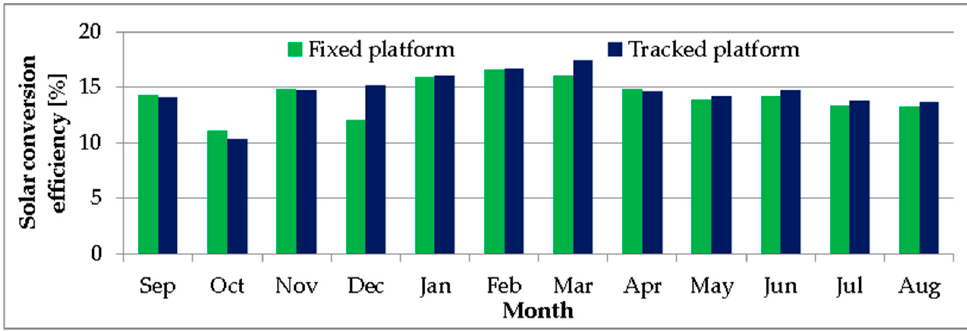
Figure 18. The monthly solar conversion efficiencies of the fixed and tracked PV platforms.